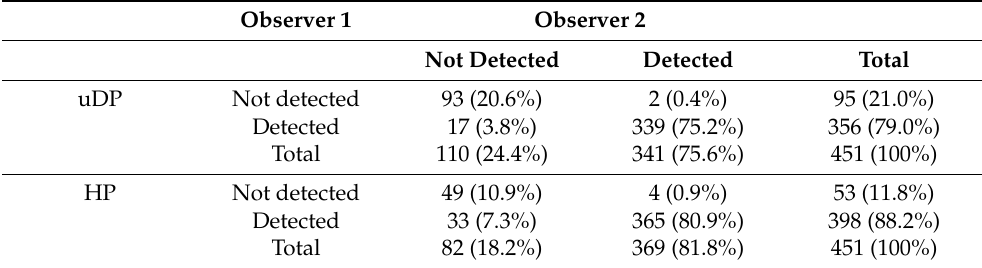
Table 2. Contingency table for the detection of metastatic lesions by observer 2 vs. observer 1 separately for unenhanced and dynamic phase (uDP) and hepatobiliary phase (HP) images. Observer 1 Observer 2